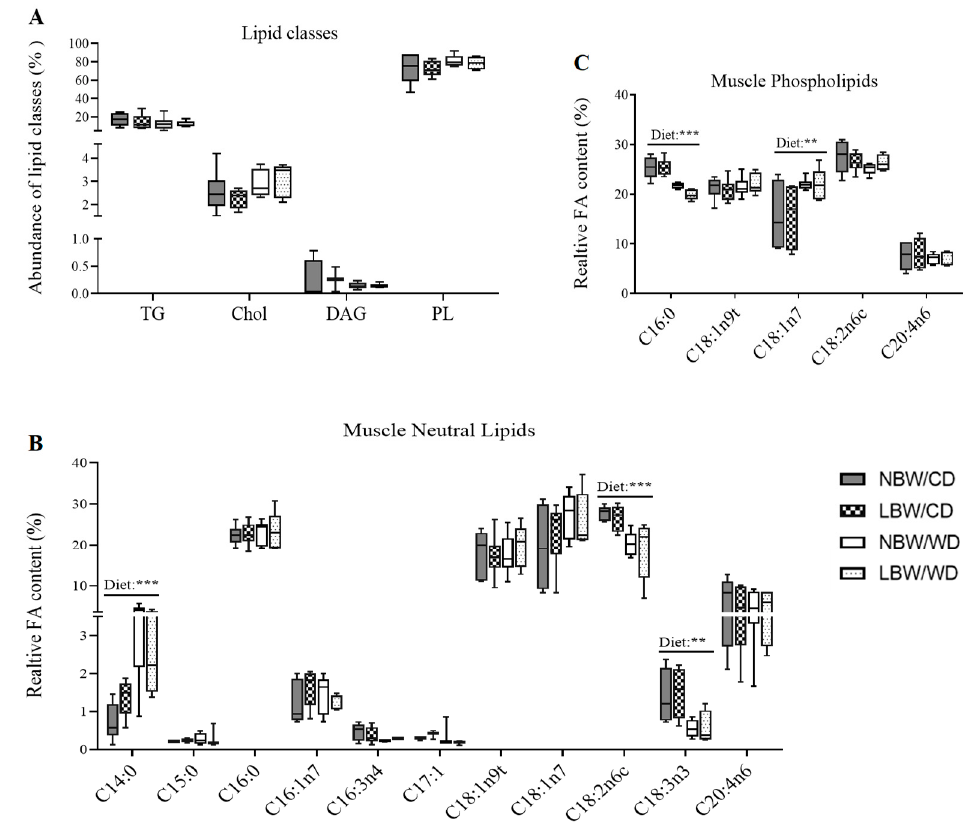
Figure 7. Relative abundance of lipid species and fatty acid profiles at postnatal day 145. ( A ) Relative abundance of lipid species, including triglycerides (TG), cholesterol (Chol), diacylglycerols (DAG), and phospholipids (PL), are displayed. Fatty acids in neutral lipid ( B ) and phospholipids ( C ) fractions are displayed. Data are min. to max. box and whisker plots for 4 to 6 animals/experimental group. **, and *** indicate p < 0.05, p < 0.01, and 0.0001, respectively, for the main effect of diet using a regular two-way ANOVA.